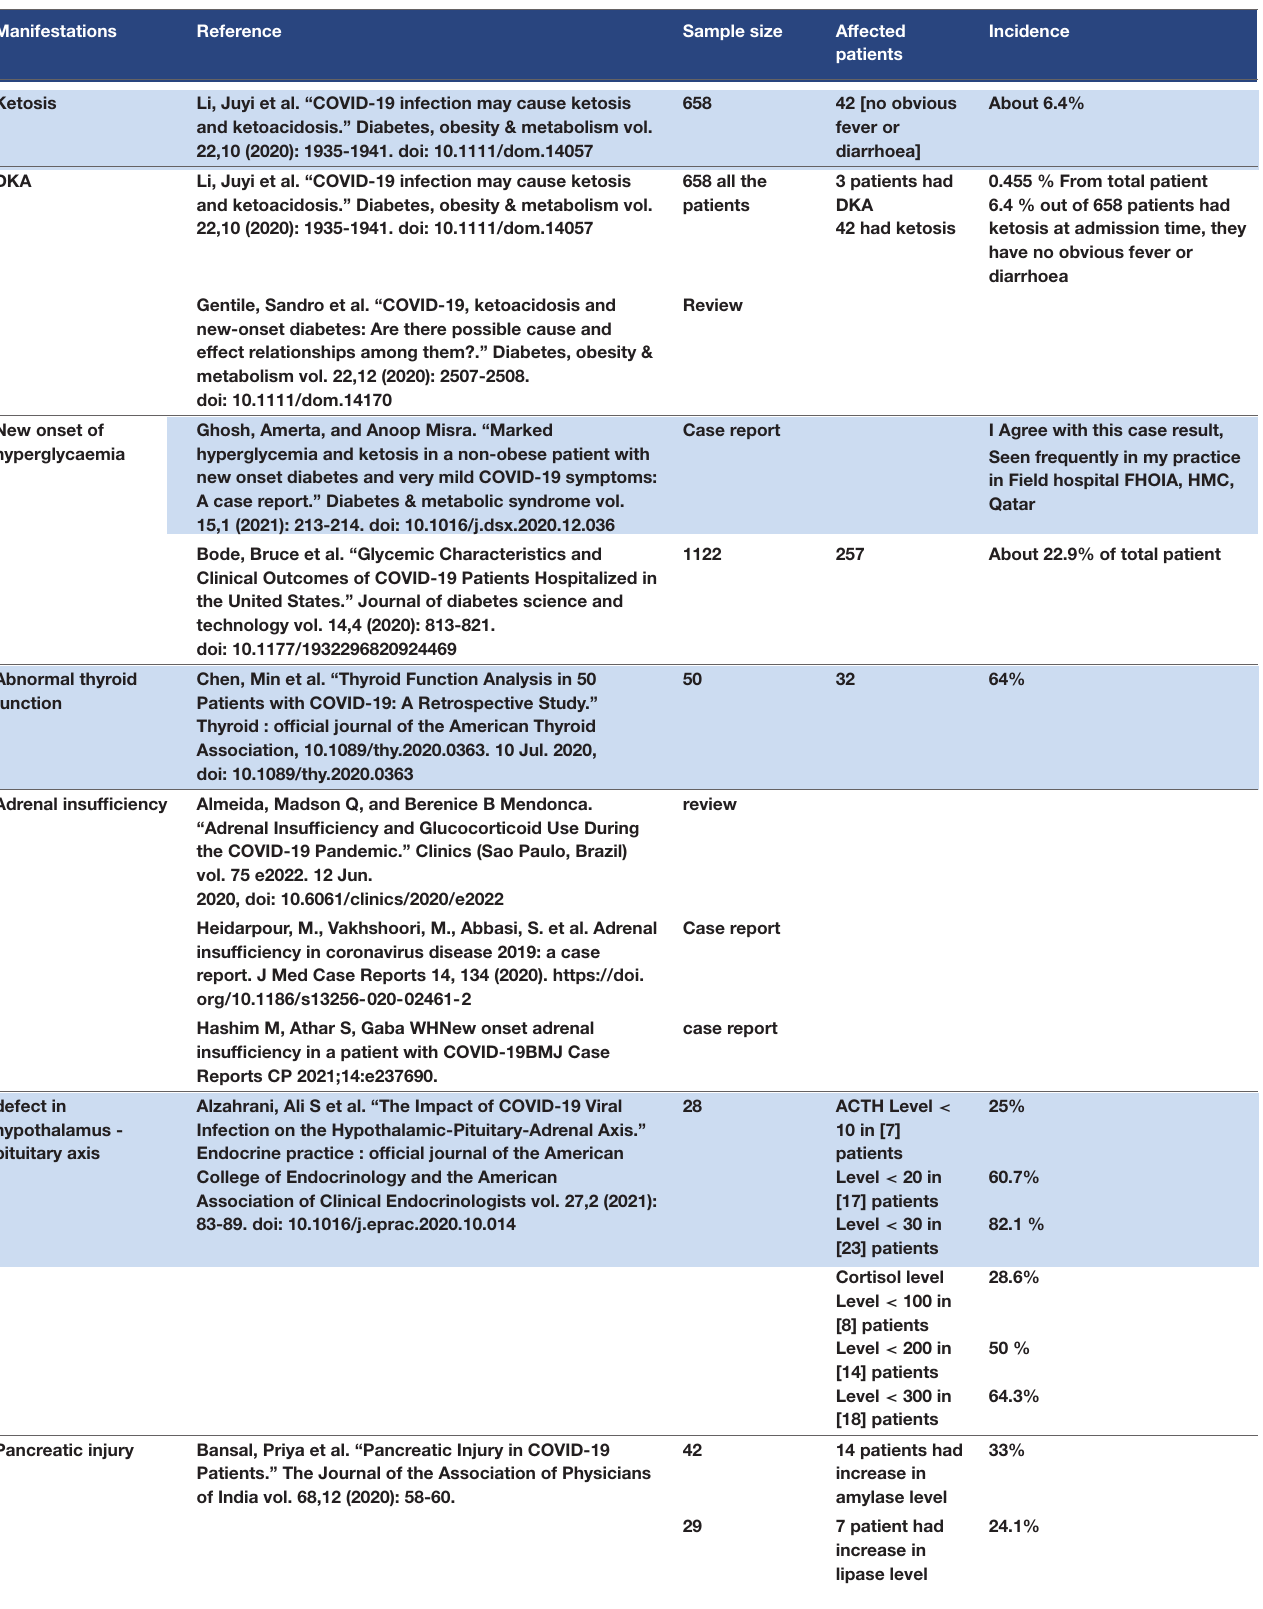
TABLE 9 | Endocrine manifestation of COVID